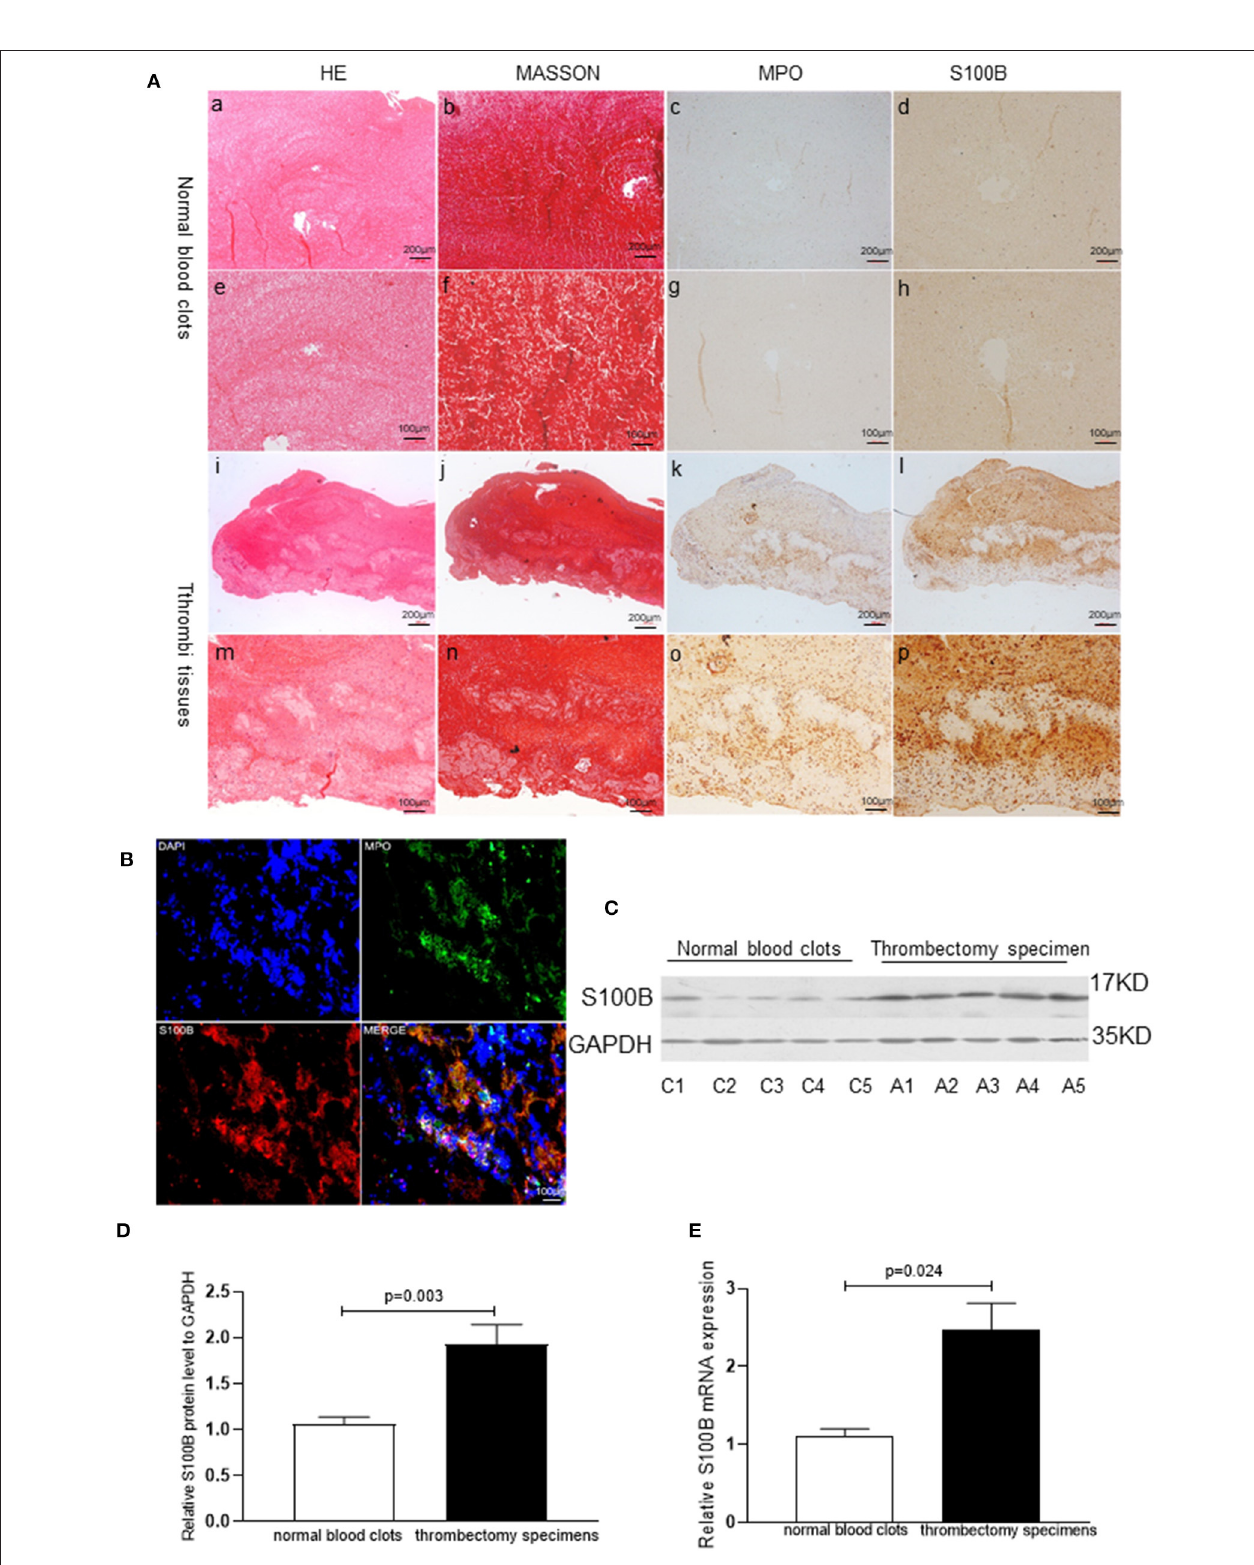
FIGURE 3 | S100B expression in human thrombi tissues of AMI patients. (A) Representative images showing the immunohistochemical staining of MPO and S100B in thrombi tissues coming obtained from AMI patients. Normal blood clots: a, b ( × 10) and e, f ( × 20): Thrombi tissues: i, j ( × 10) and m, n ( × 20). S100B expression